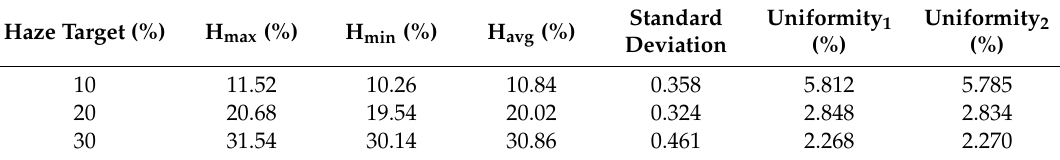
Table 8. The results of the sandblasting process for haze targets of 10%, 20%, and 30%. Haze Target